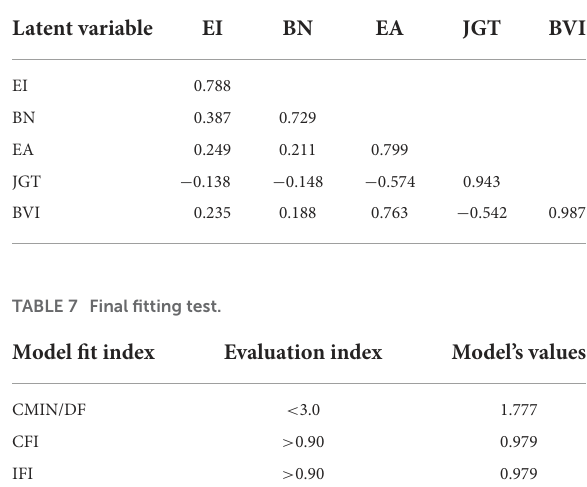
TABLE 4 Fitting test.